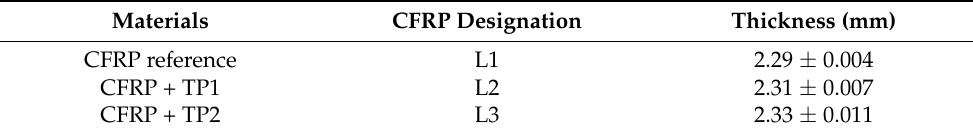
Table 2. Characteristics of the laminates manufactured for electrical and mechanical